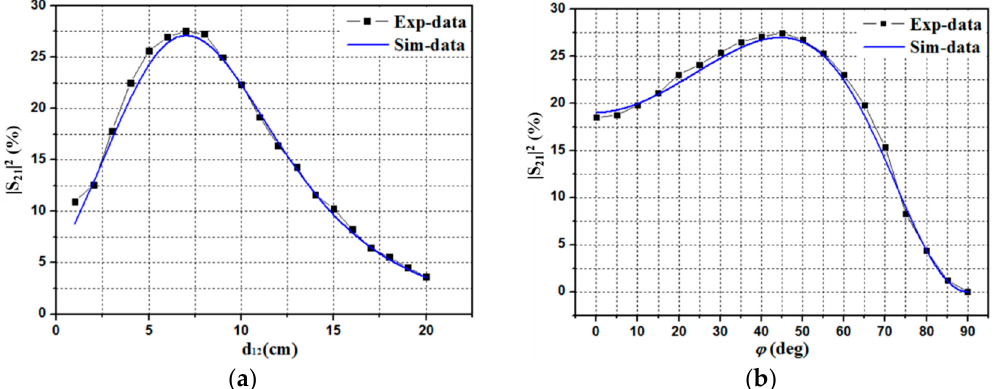
Figure 10. The transfer efficiency at a fixed transmission distance, ( a ) changes to the d 12 at fixed φ , ( b ) changes to the φ at fixed d 12 .